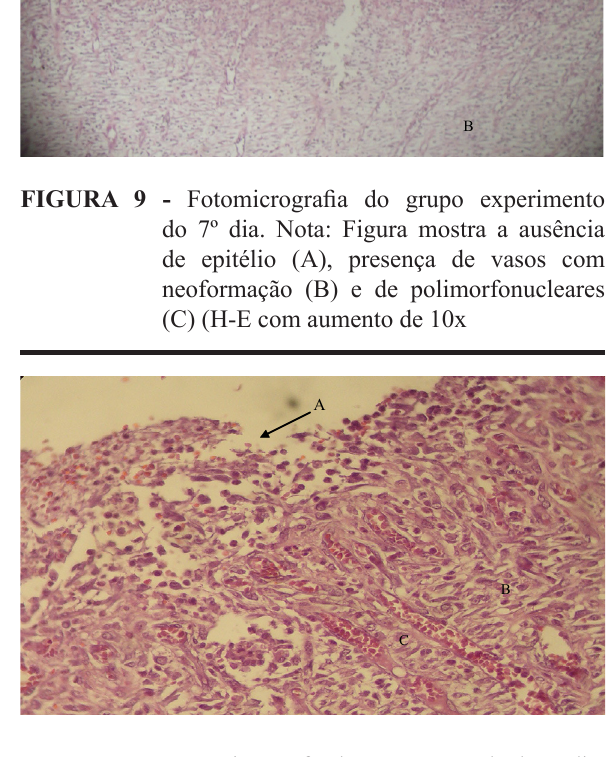
FIGURA 10 - Fotomicrografia do grupo controle do 7º dia. Nota: Figura mostra a ausência de epitélio (A), presença de vasos dilatados (B) e de polimorfonucleares (C) (aumento de